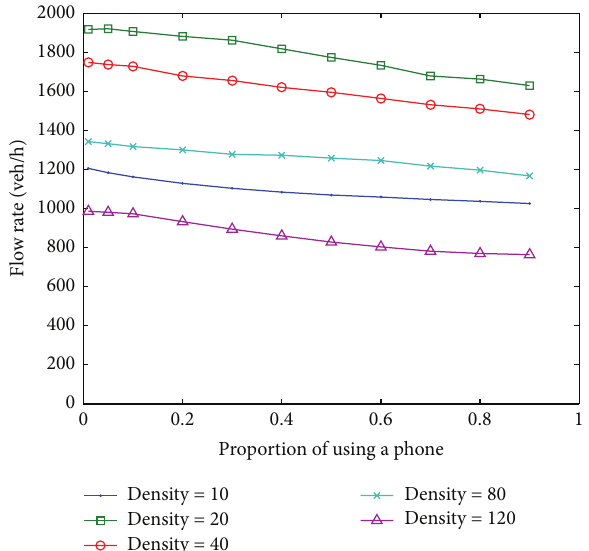
Figure 7: The relation between proportion of phone use ( 𝑝 flow